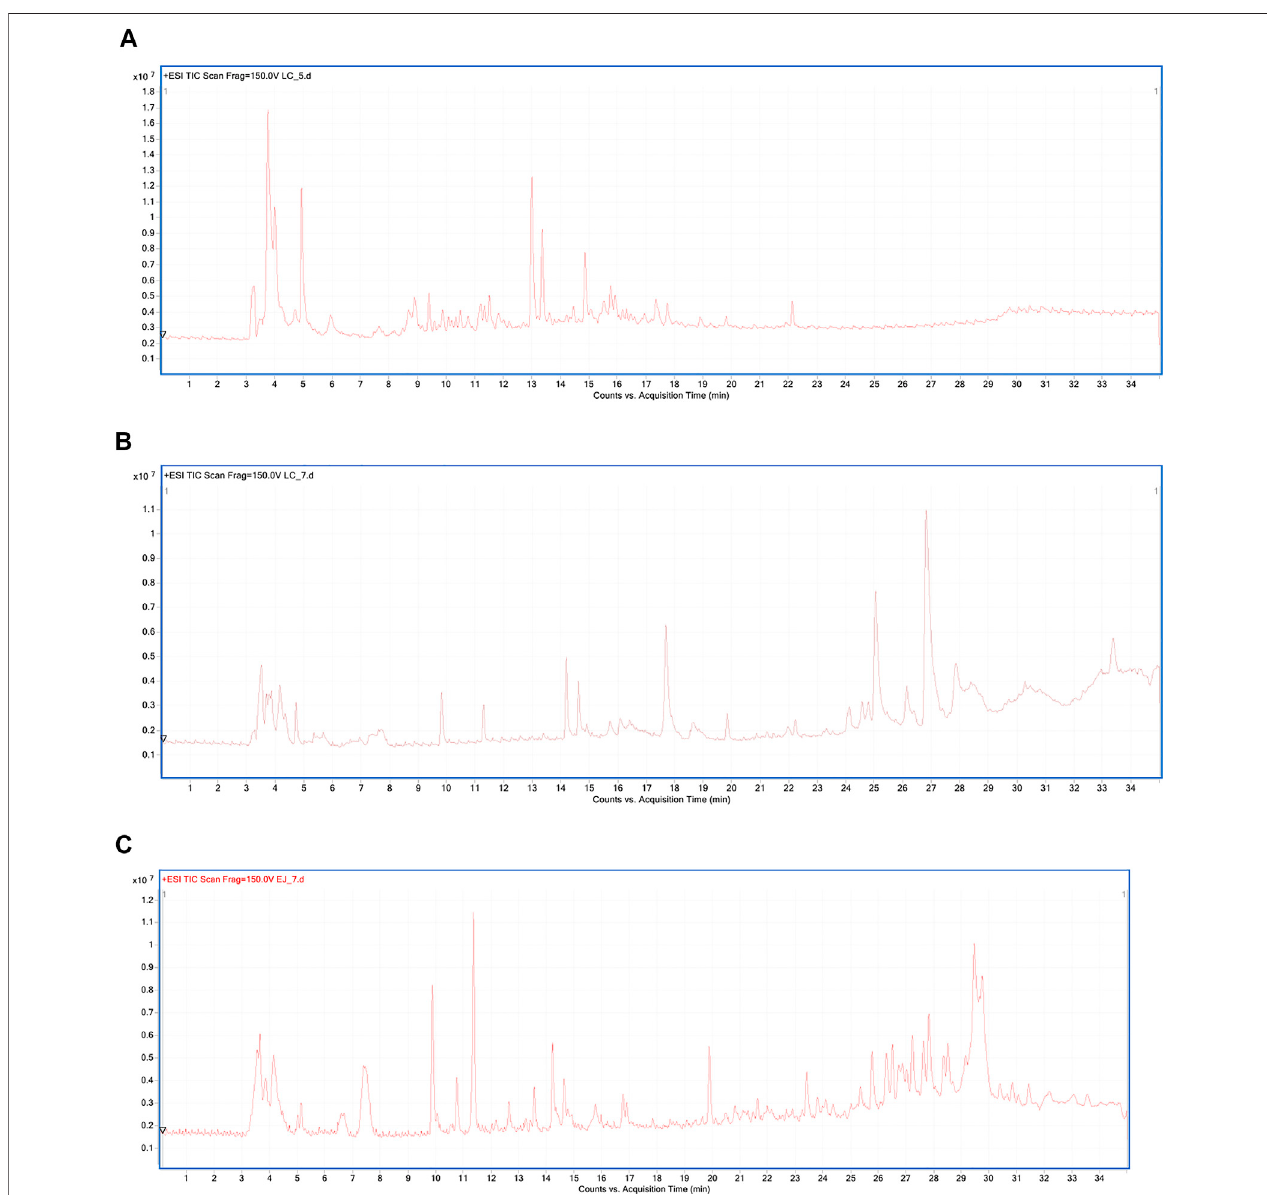
FIGURE1| Representativetotalionchromatogram(TIC)ofurine (A) ,serum (B) ,andsemen (C) metabolic fi ngerprintsobtainedwithLC-ESI-TOF/MSanalysisinthe positive ionization mode.